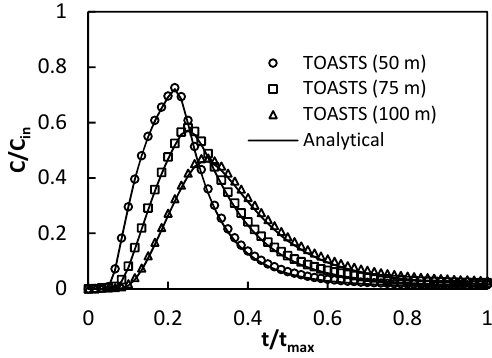
Figure 3. Results of the TOASTS model verification by the analyt- ical solution for Heaviside boundary condition ( α (cid:54)= 0).